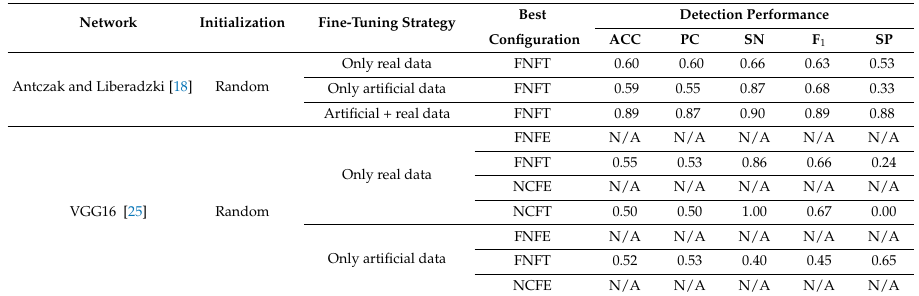
Table 6. Network detection results. The testing set of 125 real XCA patches was used to evaluate the detection performance for each best neural network configuration applied to VGG16, ResNet50, and Inception-v3 with the weights initialization: ImageNet and random (trained from